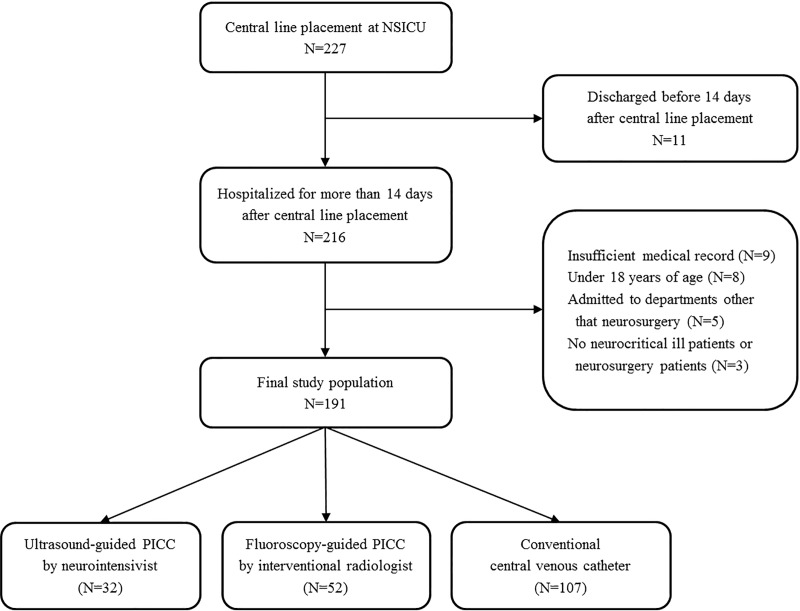
Study flow chart.NSICU, neurosurgery intensive care unit; PICC, peripherally-inserted central venous catheter.